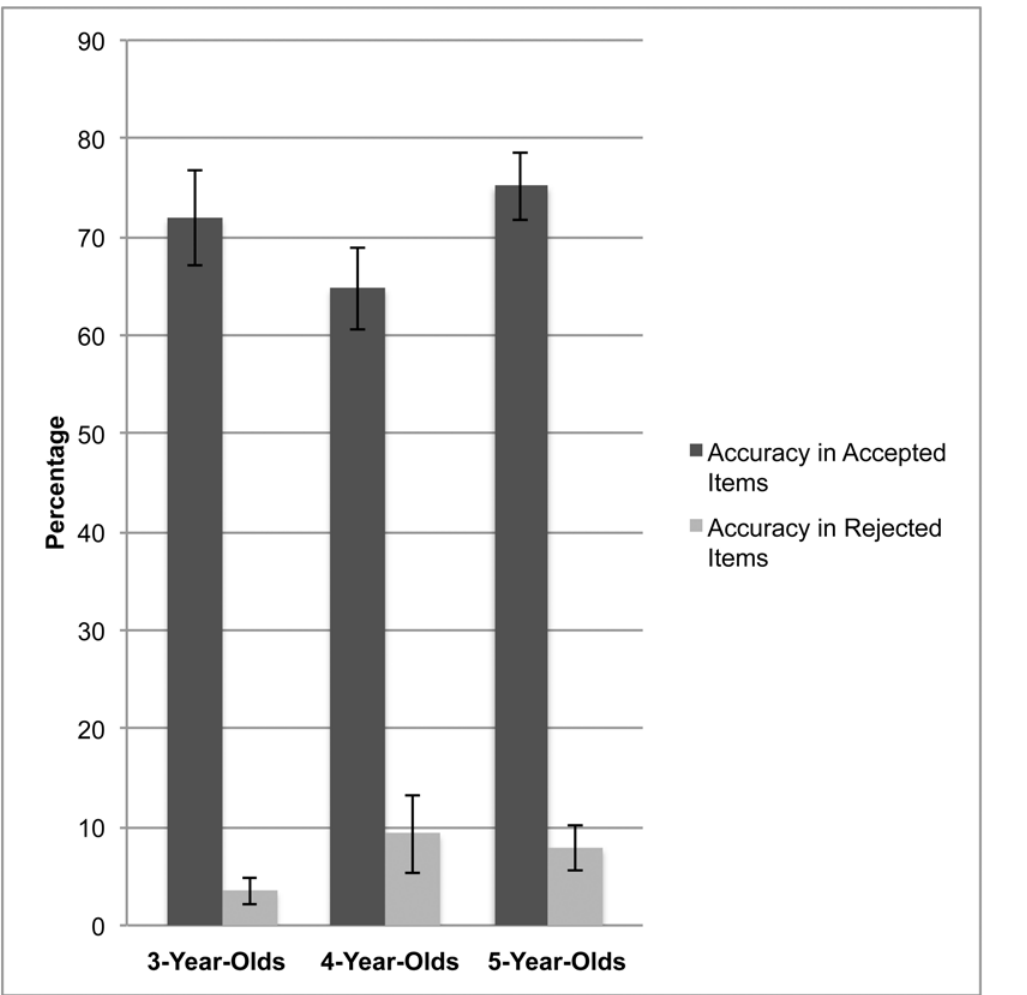
Fig 1. Percentage of accuracy for accepted and rejected items in each age